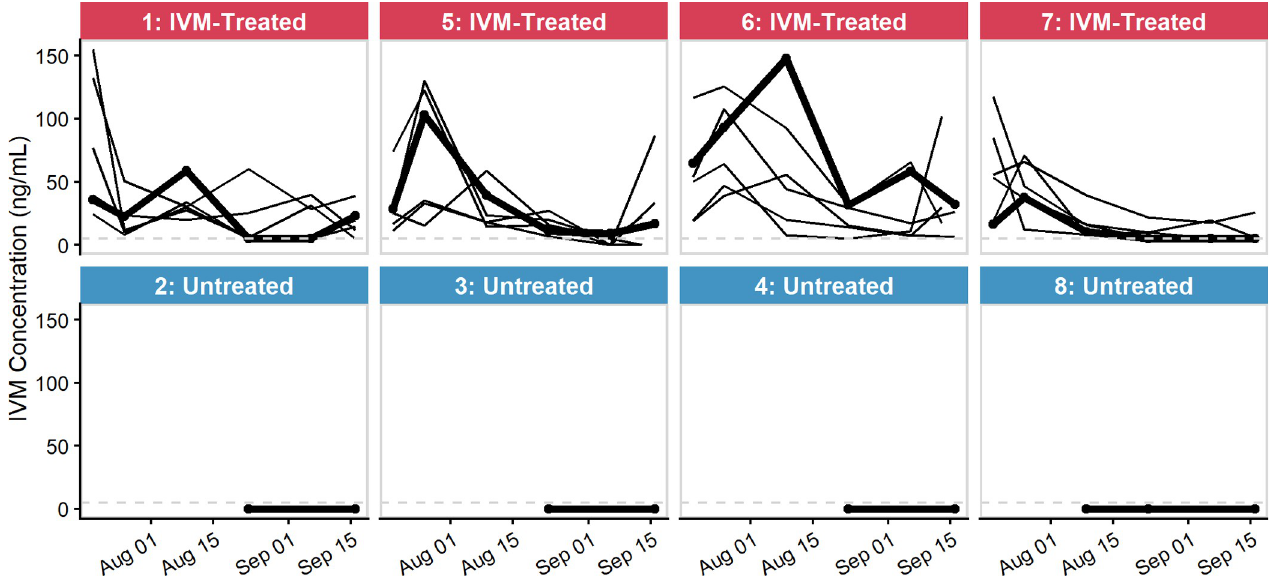
Fig 4. Ivermectin (IVM) serum concentrations (ng/mL) in treated and untreated chickens. Grey dashed line indicates the limit of quantification (LOQ, 5 ng/mL). Bold line indicates chicken used in mosquito bioassay at end of